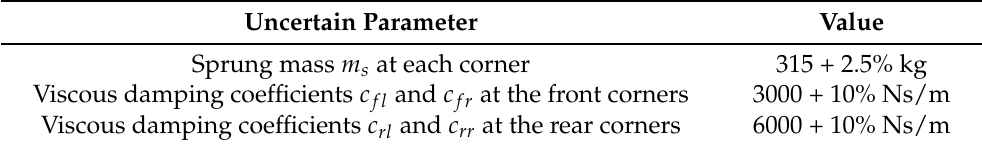
Table 5. Uncertain